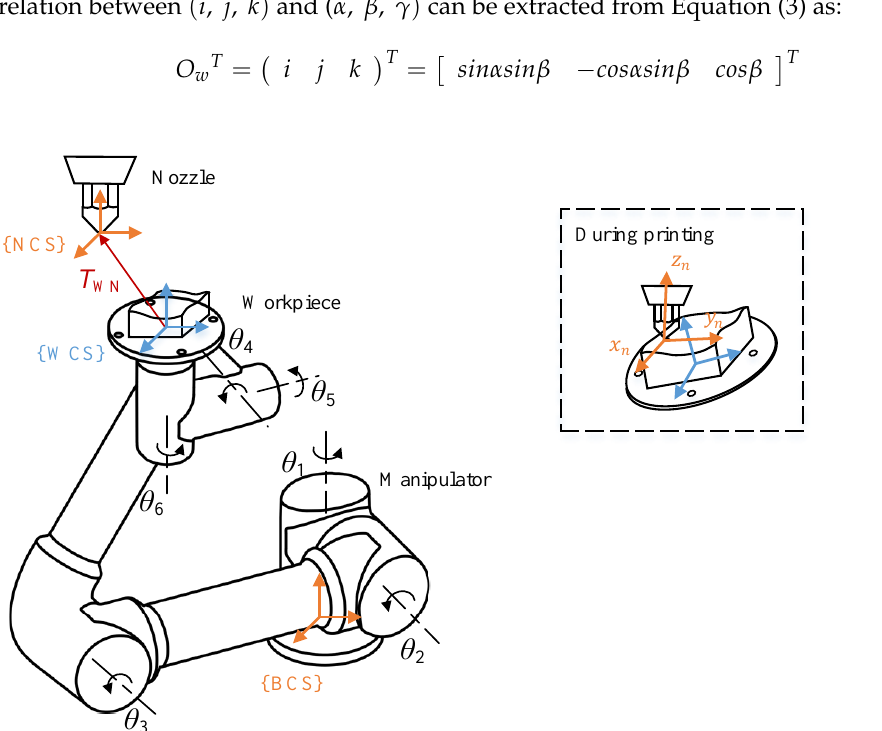
Figure 4. UR5 robotic manipulator with a nozzle.